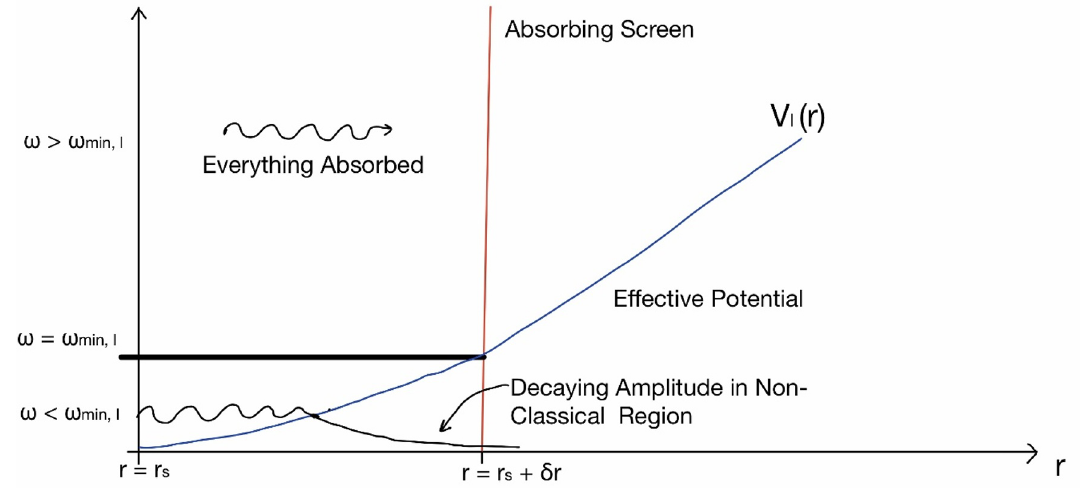
Figure 3 . Above is a depiction of how perturbations behave near the horizon with a generalized greybody factor given in eq. (2.23). For ω min ,‘ the model is unchanged and everything is absorbed. However, for ω < ω min ,‘ we account for the wave-like behaviour of the solution which allows for the solution to tunnel into the classically forbidden region. The amplitude the solution would decay as some power law after the classical turning point. We estimate the amount of energy that tunnels to the absorptive surface by taking the ratio between the amplitude of the solution at the turning point and the amplitude at the absorptive surface. Doing this gives a power law suppression of the generalized greybody factor for ω < ω min ,‘ in eq.